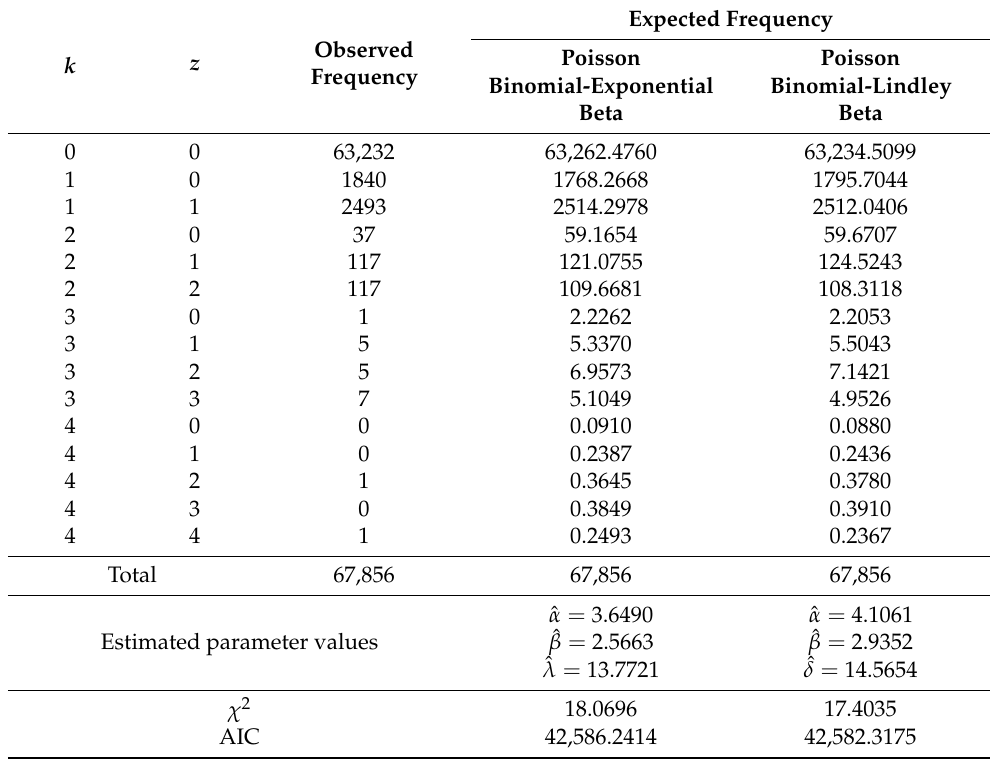
Table 2. Observed frequency and expected frequency for estimated parameter values for the number of claims ( k ) and the total number of claims with claim size larger than a limit value ( z ) with Φ = 500. Expected Frequency Observed Poisson Poisson k z Frequency Binomial-Lindley Binomial-Exponential Beta Beta 0 0 63,232 0